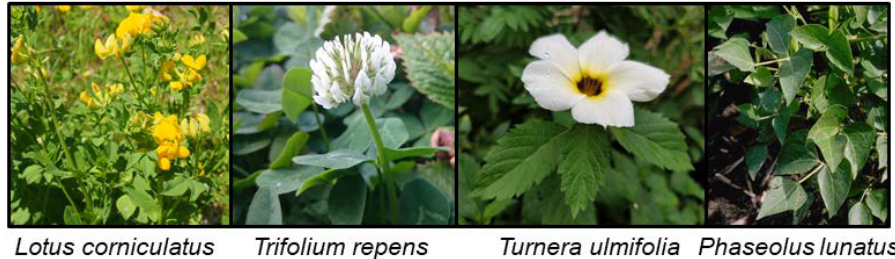
Figure 5. L. corniculatus photo by Mika Zagrobelny, T. repens and T. ulmifolia photos by Érika Cristina Pinheiro de Castro, and P. lunatus photo by Howard F. Schwartz (https://www.forestryimages.org/browse/detail.cfm?imgnum=5357638).